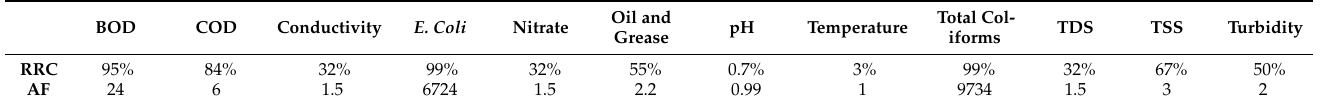
Table 6. River recovery capacity and accumulation factor for physicochemical parameters of Ngong River wet season.